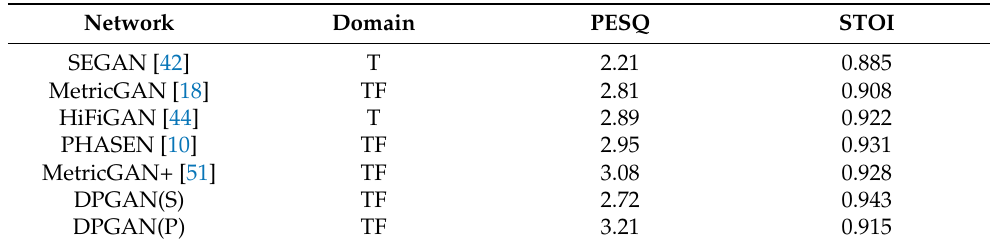
Table 2. Comparison of DPGAN with the other classical methods on LibriSpeech+PNL